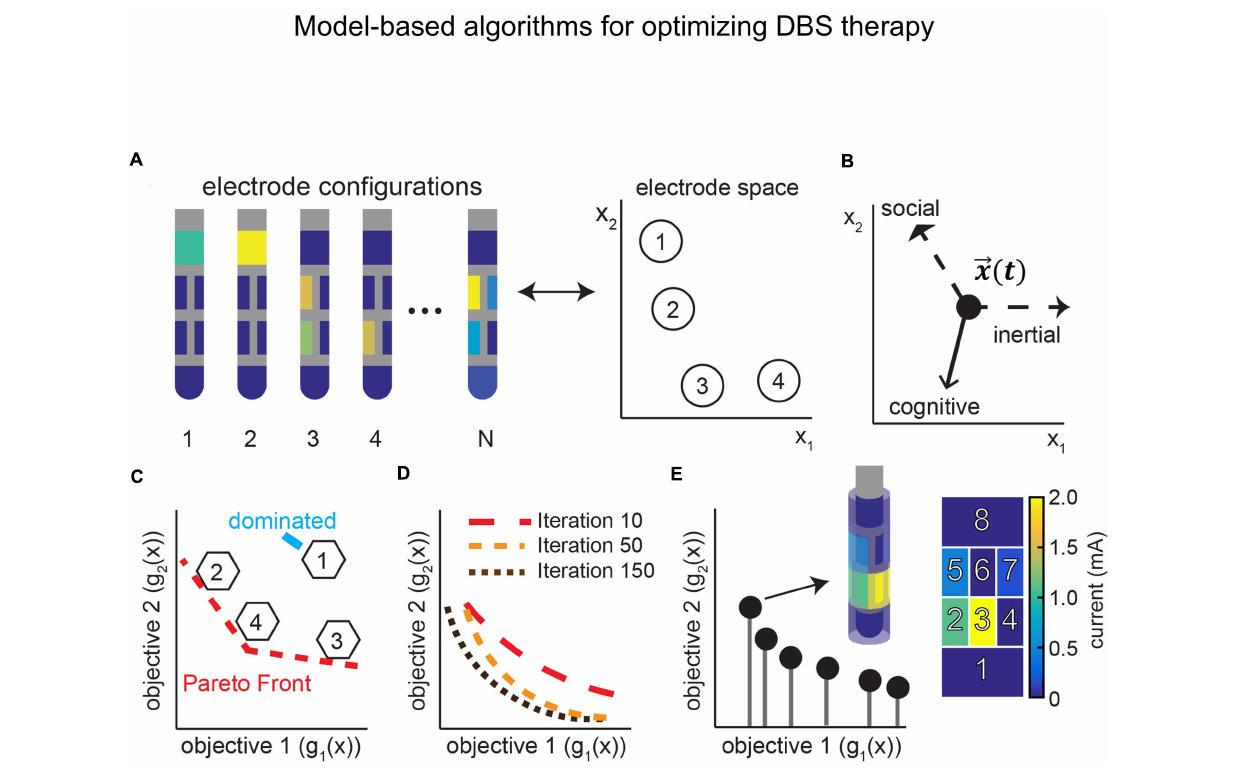
FIGURE 10 | Multi-objective particle swarm optimization algorithm for determining DBS parameter sets that more selectively active one or more axonal pathways adjacent to a DBS lead. (A) Multiple particles explore electrode configurations and stimulation amplitudes, and are guided by panel (B) , an inertial, cognitive, and social component amongst the N particles. (C–E) Particles are mapped onto a multi-objective space that describes the goal of activating one or more pathways over other pathways within the brain. Through an iterative process, non-dominated particles are tracked to create a Pareto front with particles corresponding to optimized electrode configurations. Reproduced with permission from Pena et al.